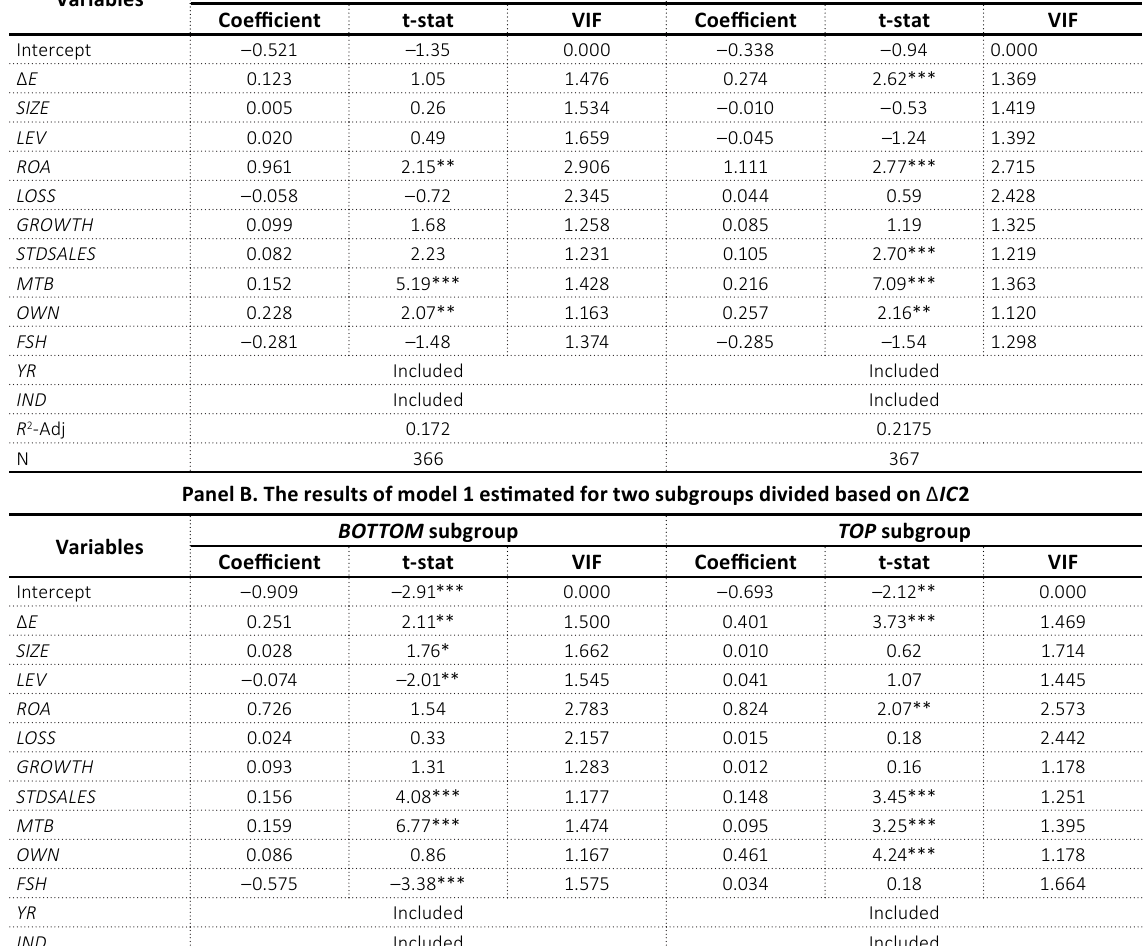
Table 4. Analysis on the value relevance of earnings for subgroups Panel A. The results of model 1 estimated for two subgroups divided based on Δ IC 1 Variables